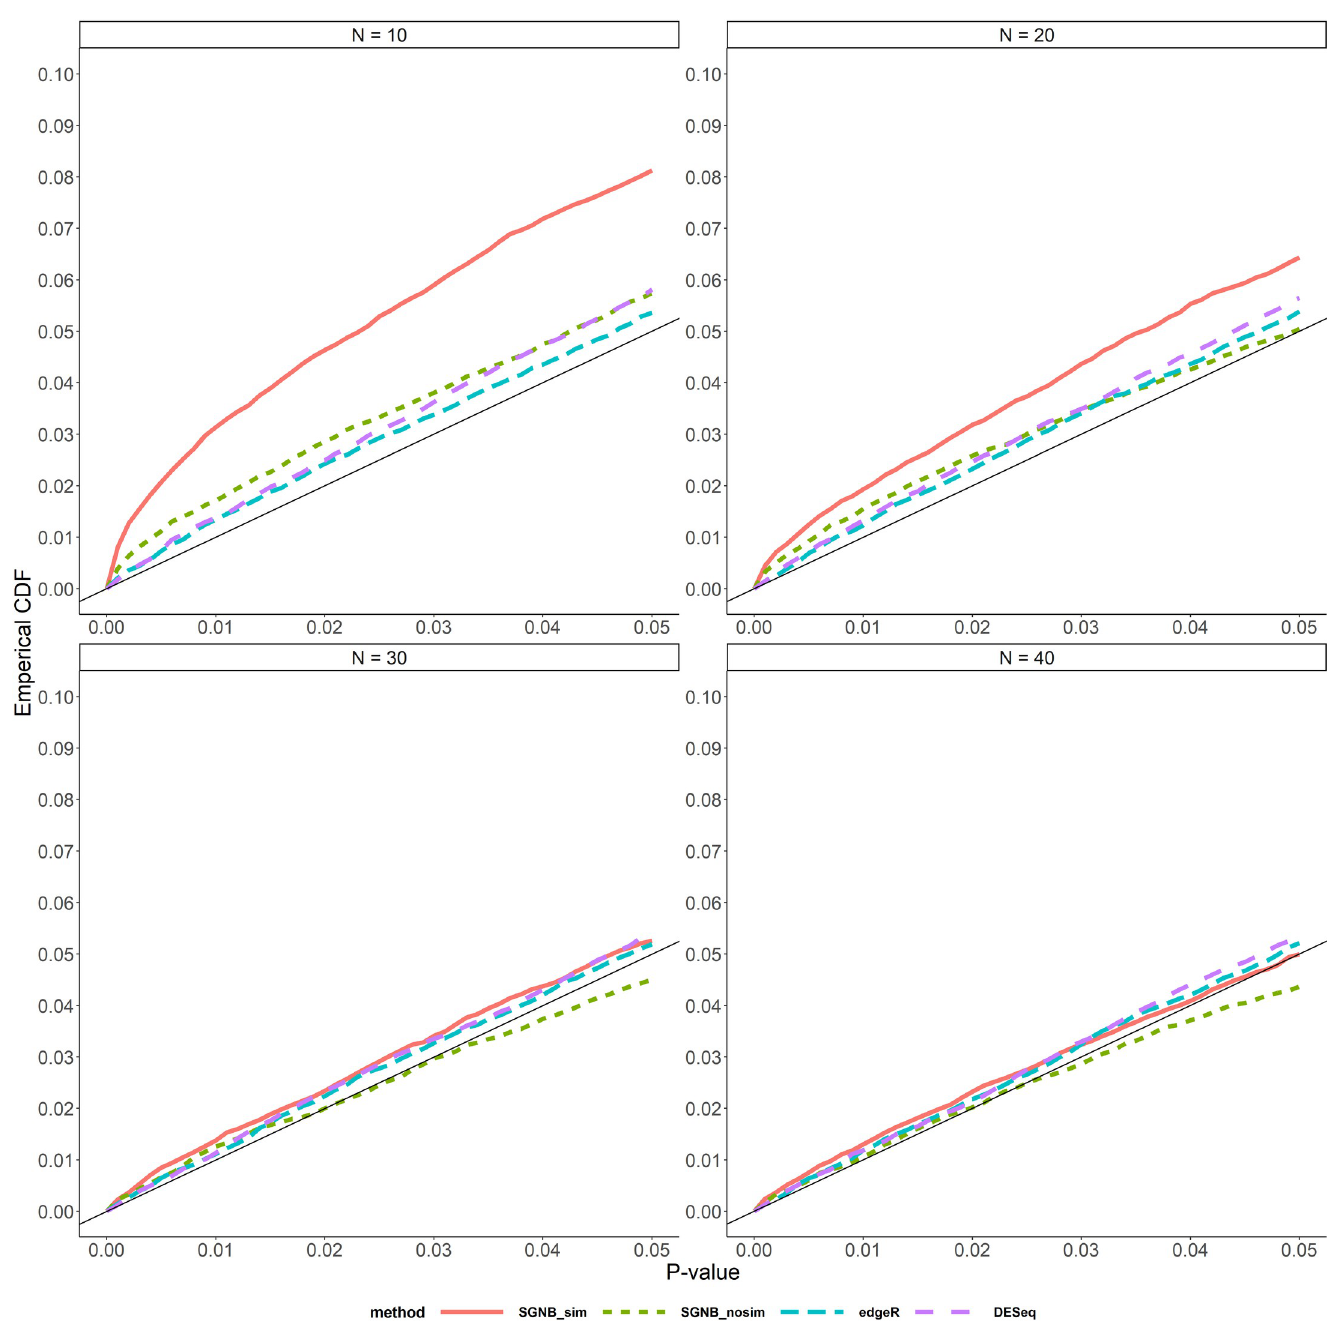
Fig 3. Type I error control with small dispersion by P-value < 0.05. small, SGNB without model simplification performs better than SGNB with model simplifica- tion; and when the dispersion is large, they have the similar performance. Compared with edgeR and DESeq, SGNB with model simplification only can achieve a similar type I error control performance when the sample size is large, while edgeR and DESeq have a good type I error control across all the sample size settings. Also, SGNB with model simplification needs